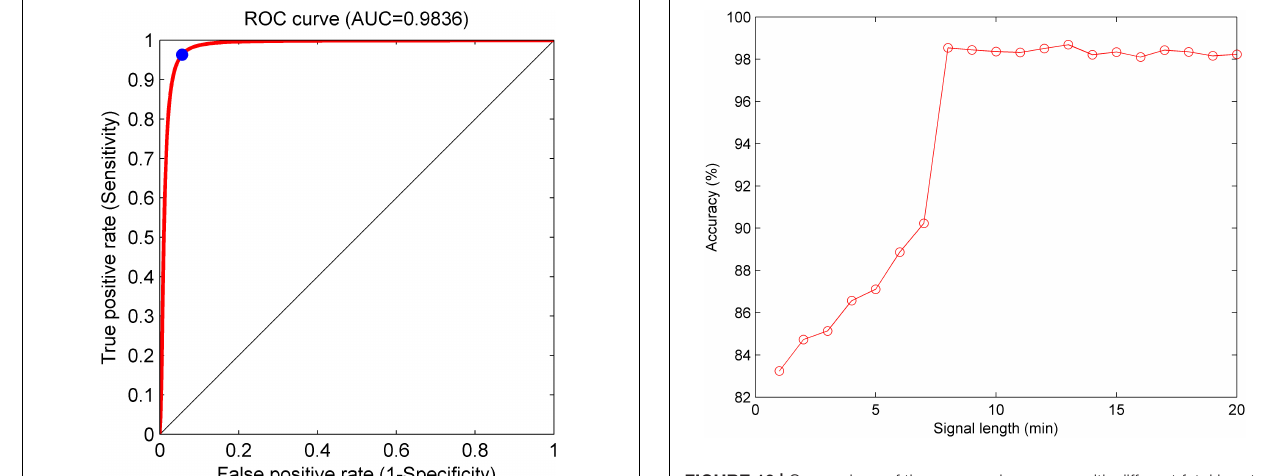
FIGURE 10 | Comparison of the averaged accuracy with different fetal heart rate (FHR) signal lengths using the test set across 10-fold for the proposed computer-aided diagnosis (CAD)